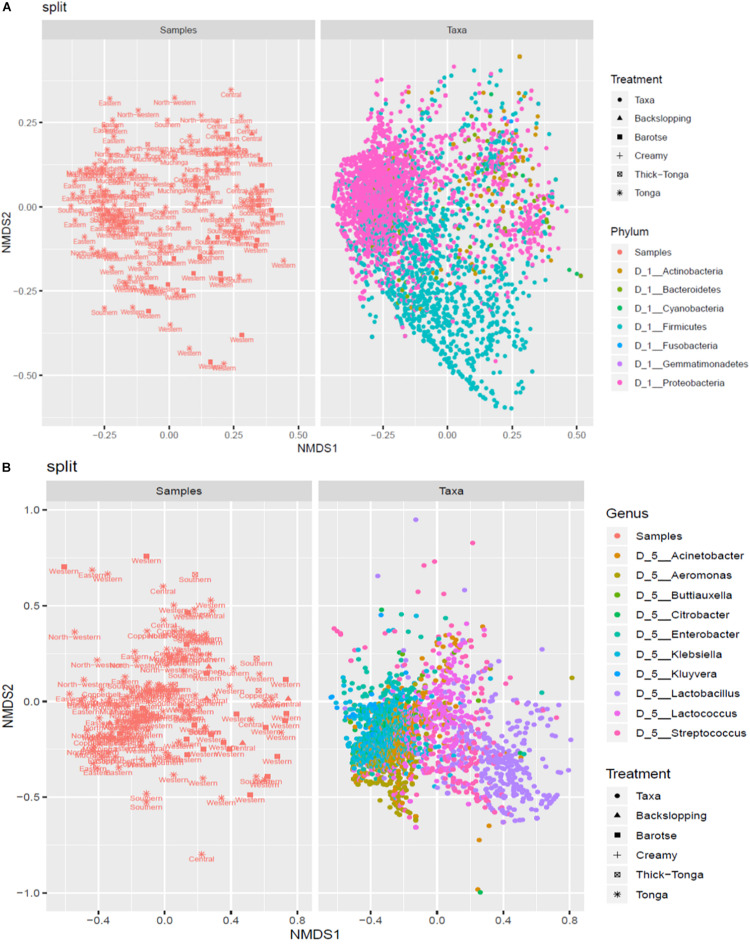
Non-metric multidimensional scaling (NMDS) plot of the relationship between taxa and location and production method at (A) phylum level and (B) genus level.